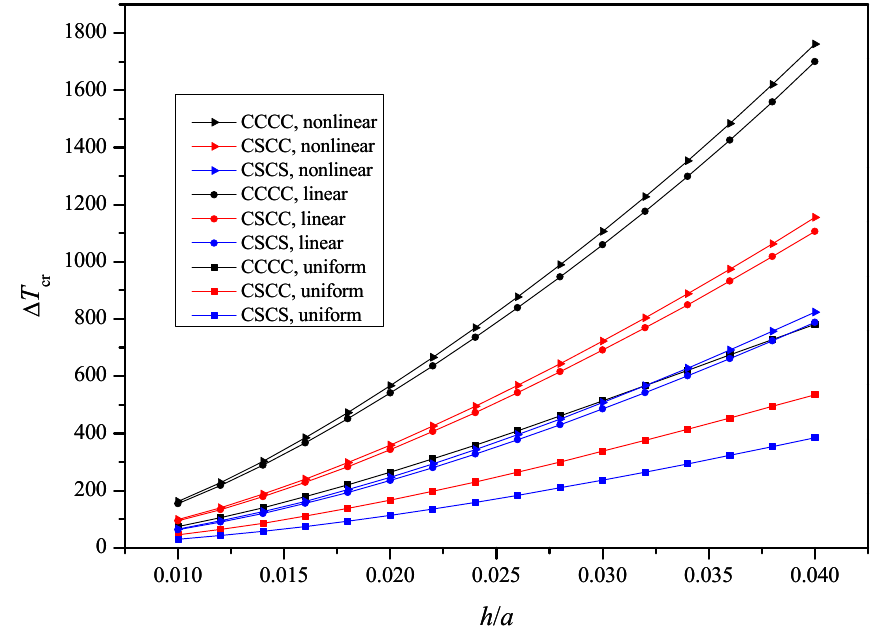
Figure 3. The relation between the critical buckling temperature Δ T cr and the length–thickness ratio h / a of type-I FGM rectangular thin plate ( a / b = 2, n = 2, T 0 = 300 K). Appl. Sci. 2017 , 7 , 1256